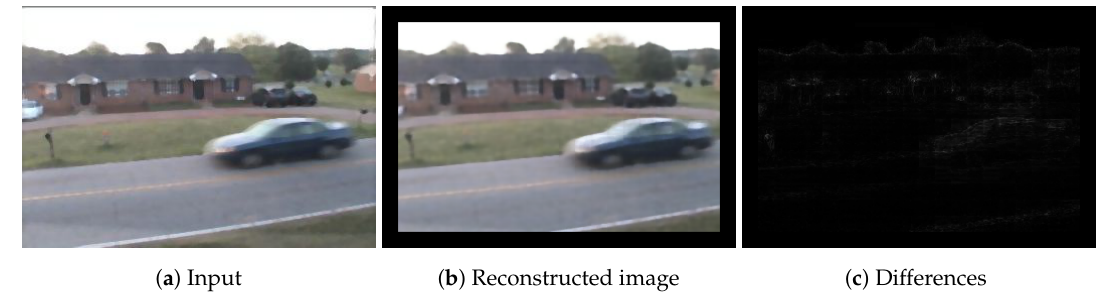
Figure 1. Reconstruction using an autoencoder. We trained the autoencoder using patch images as reference images. We cropped patch images for a current image in ( a ) and reconstructed each patch in ( b ). It is difficult to select a threshold value to distinguish the foreground clearly using the differences, as shown in ( c ).